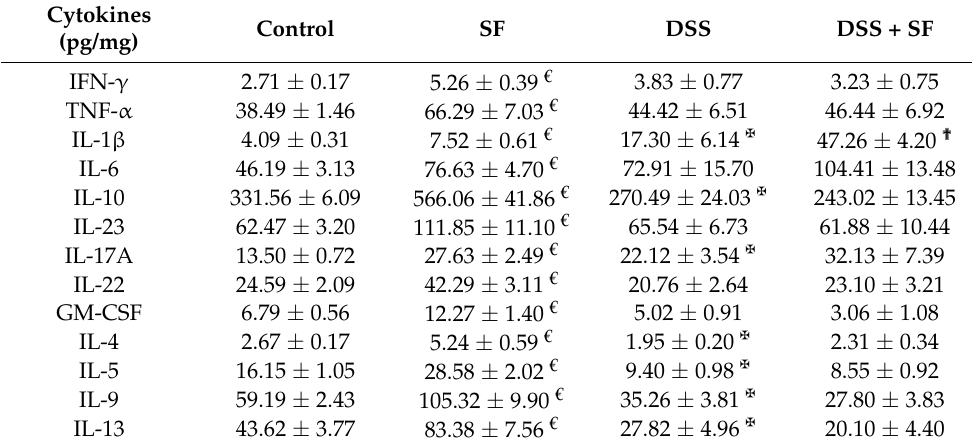
€ represent the control group versus SF group; (cid:64) represent the control group versus DSS group; (cid:63) represent the DSS group versus DSS + SF group; € , (cid:64) , (cid:63) , p < 0.05; n = 4 in each